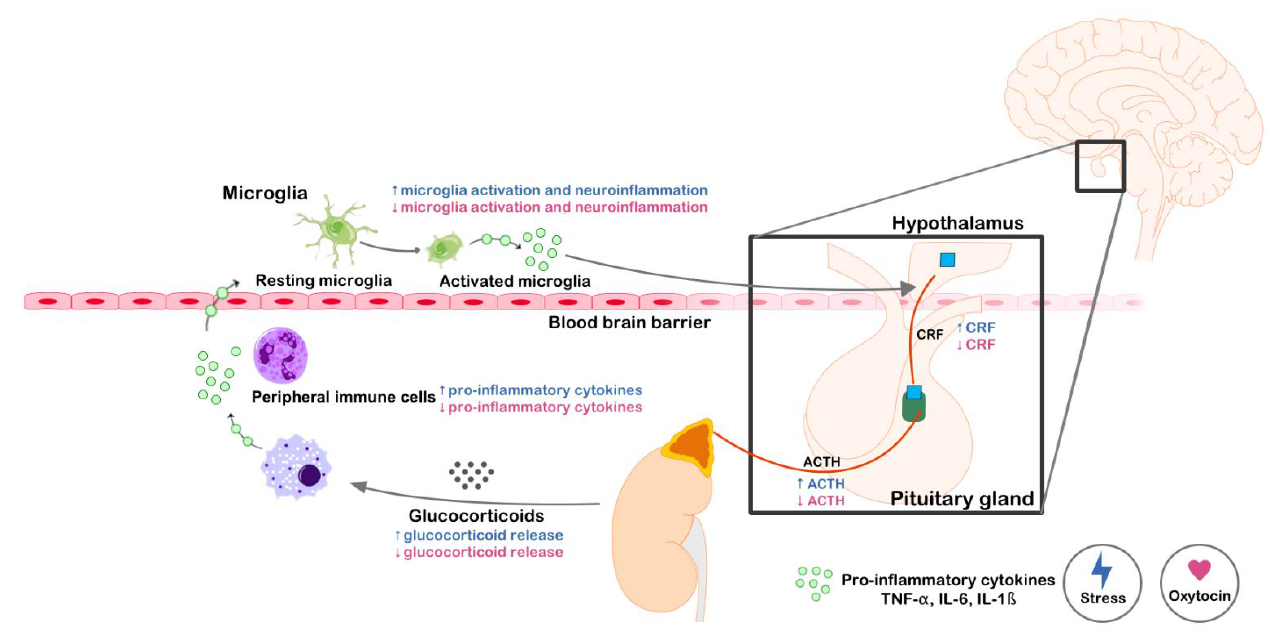
Figure 2. Oxytocin modulates the inflammatory response induced by stress. The effects of stress are depicted in blue, and those of oxytocin in pink. Stress activates the hypothalamic–pituitary–adrenal (HPA) axis and promotes the release of glucocorticoids that turn peripheral immune cells into a primed state. The activation of stress-primed immune cells can induce an exaggerated inflammatory response that eventually reaches the brain and promotes the activation of resident immune cells (neuroinflammation). Activated microglia within the brain release inflammatory cytokines that activate the HPA. Oxytocin counteracts the effects of stress in all the stages of this loop.